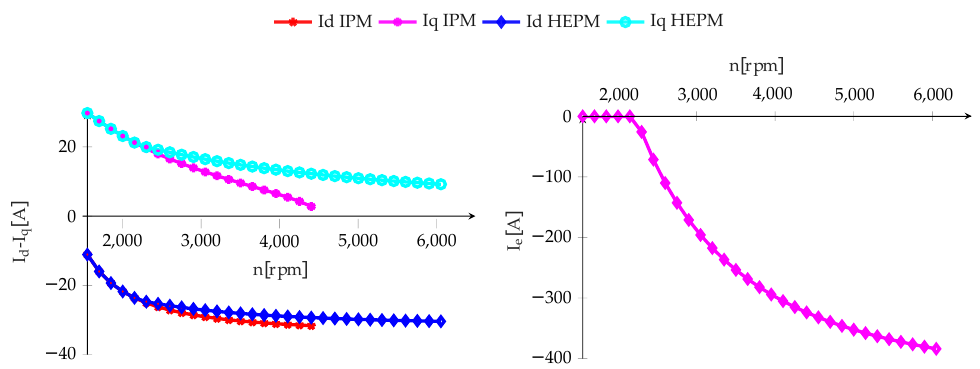
Figure 6. Rotor current and I d − I q in HEPM and IPM motors and Excitation current I e in HEPM